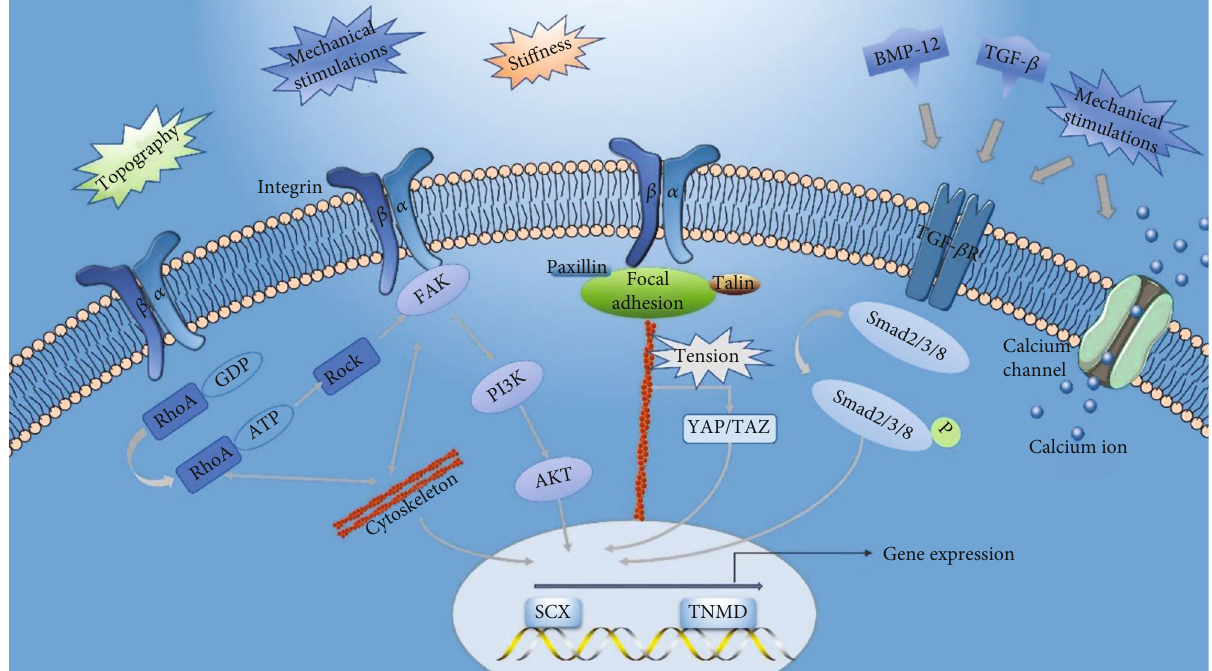
Figure 4: Signal transduction of mechanical loading in tenogenic di ff erentiation. The mechanical stimulations and the mechanical properties of substrate including topography and sti ff ness can activate the integrins, which causes the changes of downstream signaling molecules and results in tenogenic di ff erentiation. The mechanical stimulations and growth factors both can activate the TGF- β receptors, inducing tenogenic di ff erentiation. The mechanical stimulations can open the calcium channel and bring about the in fl ow of Ca 2+ , which regulates tenogenic di ff